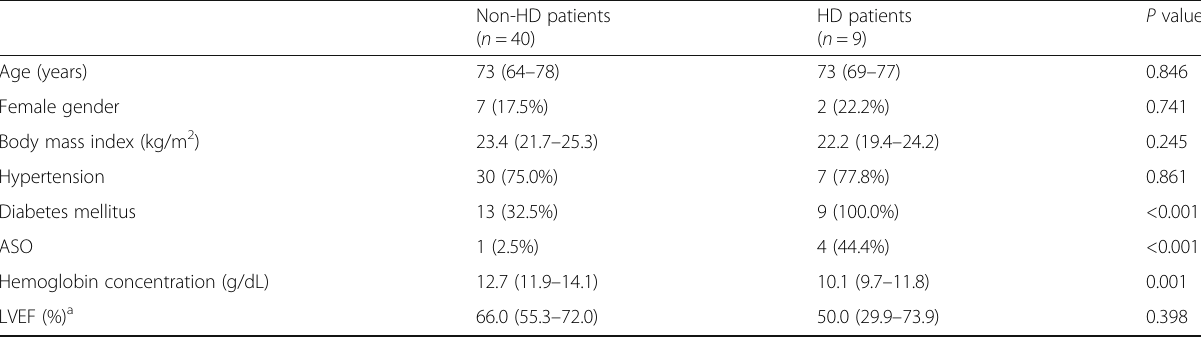
Table 1 Patient characteristics stratified by